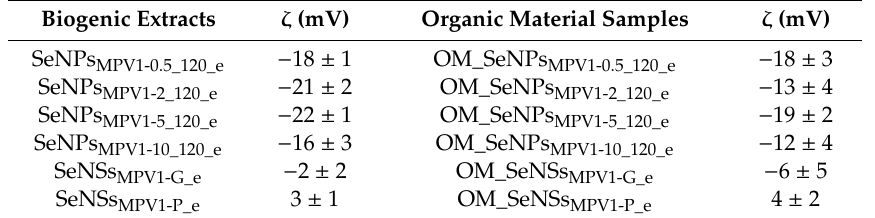
Table 6. Surface charge ( ζ ) of biogenic SeNS extracts and their supernatants removed from NSs. Biogenic